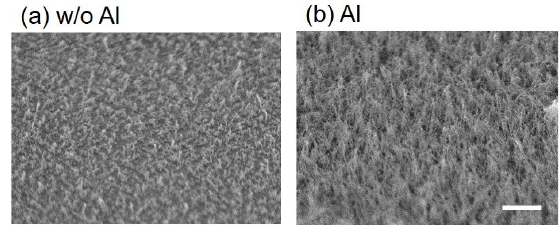
Figure 5. SEM bird’s-eye views of the sapphire surfaces after annealing without N 2 to examine the effects of Al. ( a ) Without Al (only Ar) and ( b ) with Al. In both images, scale bar represents 1 µm. There are two possible mechanisms for void formation. (A) The nitrided layers of sapphire are not